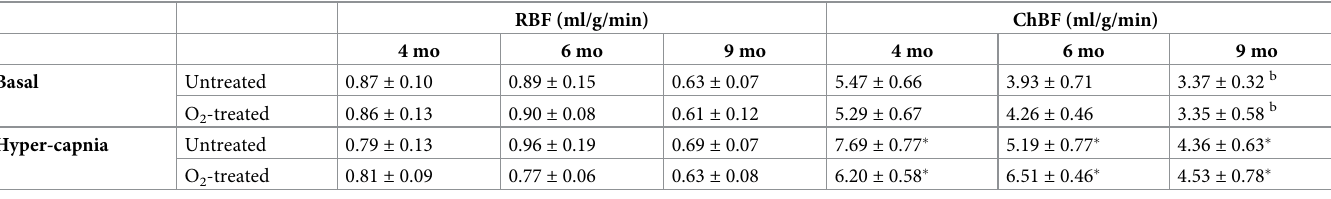
Table 2. Retinal and choroidal blood flow in untreated and 30% O 2 -treated DBA/2J mice (mean ± SEM). RBF (ml/g/min) ChBF